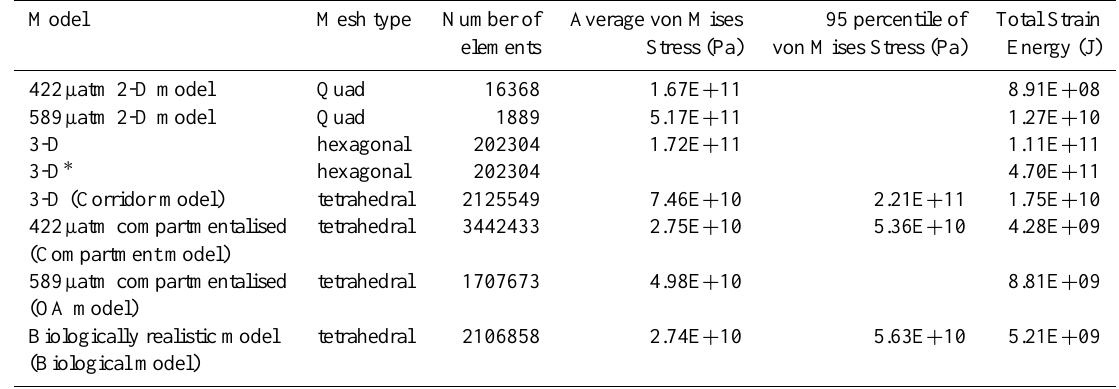
Table 1. Mesh type, number of elements, average von Mises stress, 95th percentile of von Mises stress and total strain energy for the different